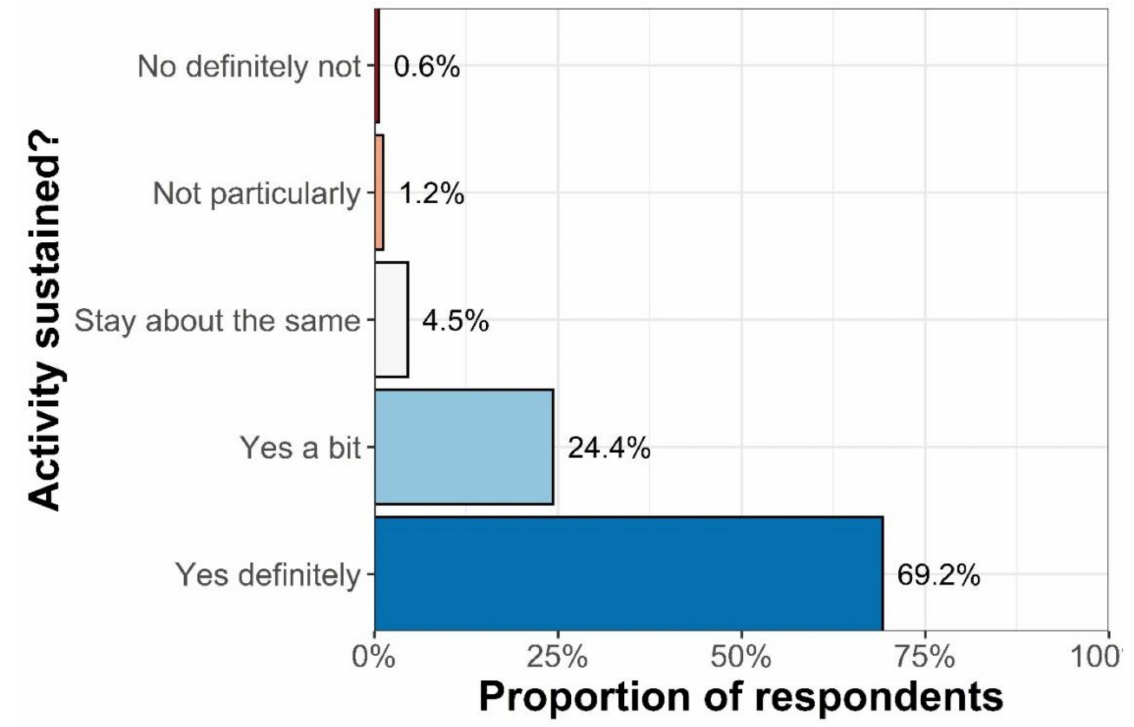
Figure 1. Likelihood of sustaining changes in individuals who had increased their outdoor physical activity during Covid restrictions ( n =